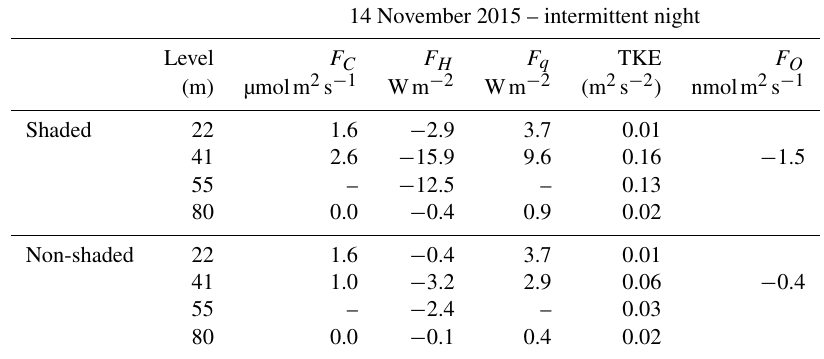
Table 2. Five-minute TKE and fluxes averaged for shaded and non-shaded areas in the intermittent night (see Fig. 2).